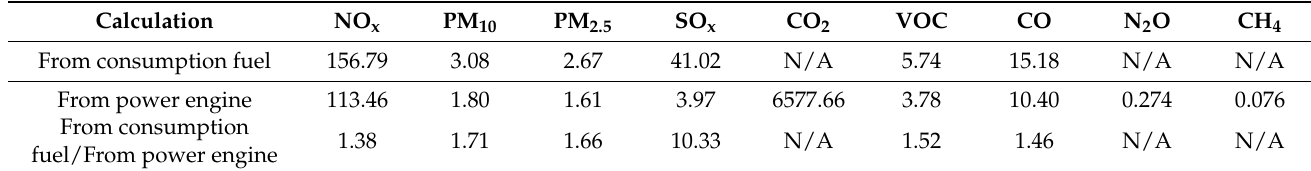
Table 14. Emissions (t/year) comparison calculation.